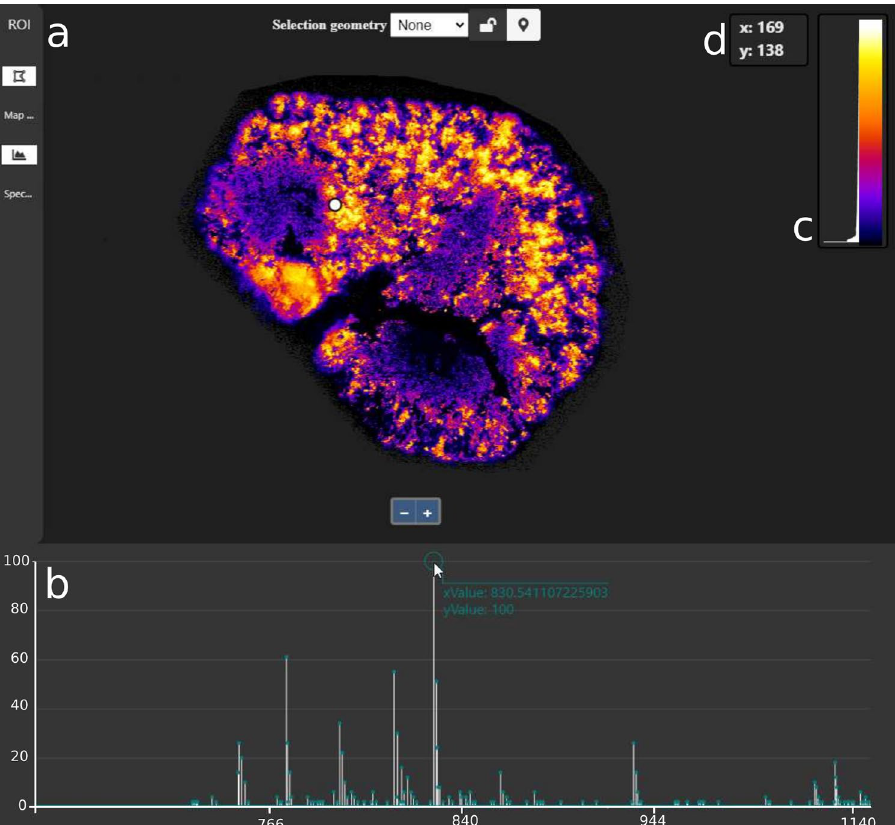
Figure 4. QUIMBI user interface. ( a ) The main panel with a selected reference pixel. The pseudocoloring shows the similarity of each pixel spectrum to the selected reference pixel. ( b ) The spectrum viewer shows the mass spectrum of the selected reference pixel. Hovering the spectrum with the mouse shows an annotation about the m / z value and the intensity at the mouse position. ( c ) Color scale legend combined with a similarity value histogram plot. ( d ) Position